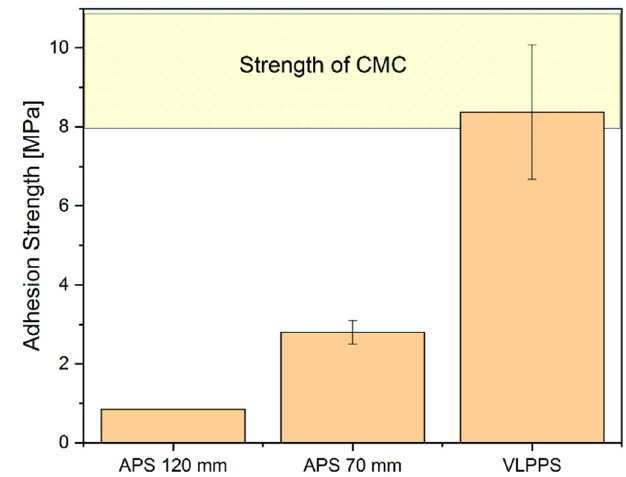
Figure 7. Measured adhesion strength of as-sprayed APS and VLPPS YAlO 3 coatings.